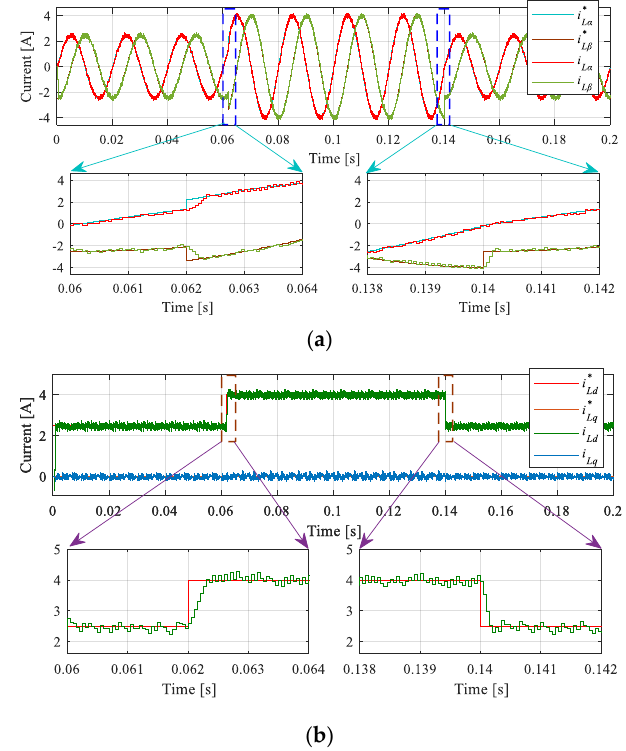
Figure 7. Simulation result: tracking performance of load current for the FS-MPC in ( a ) αβ -frame and ( b ) dq -frame.